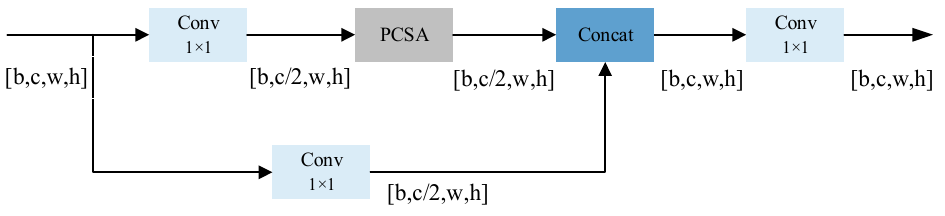
Figure 4. PCSA block structure.